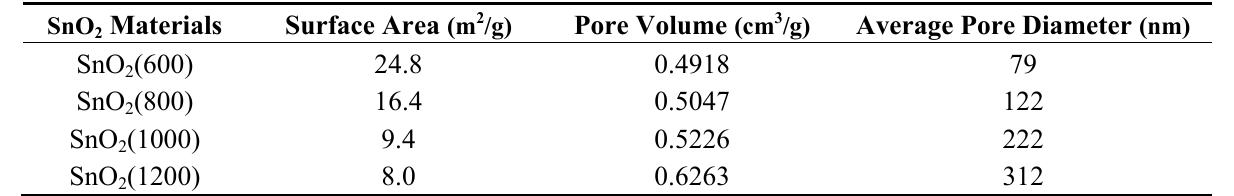
materials produced by Hg porosimetry. 2